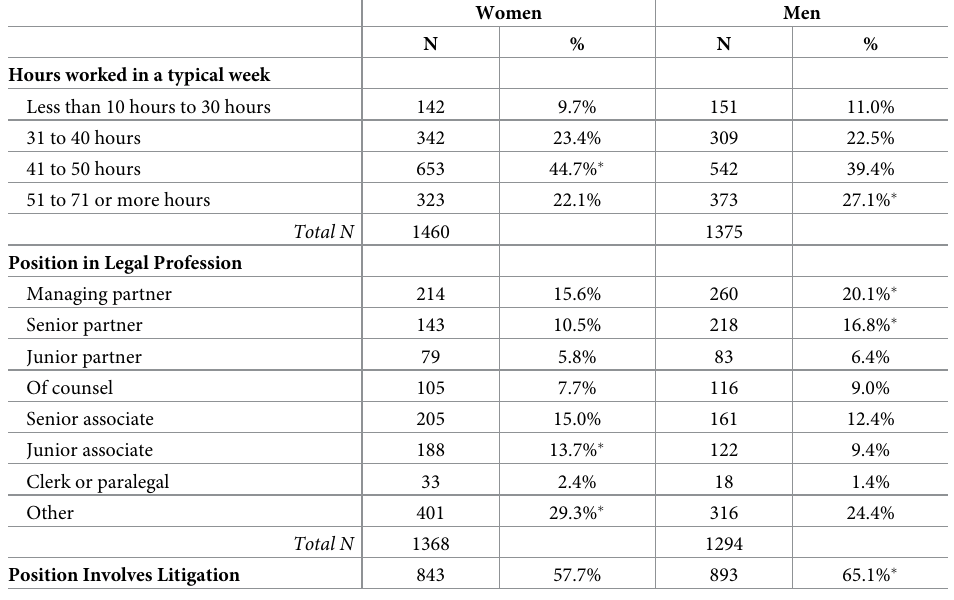
Table 2. Work-related